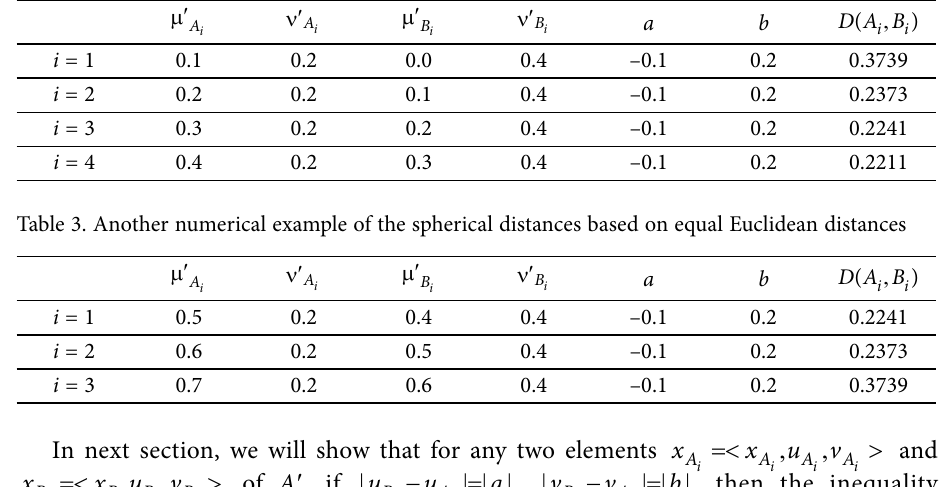
Table 2. An numerical example of the spherical distances based on equal Euclidean distances